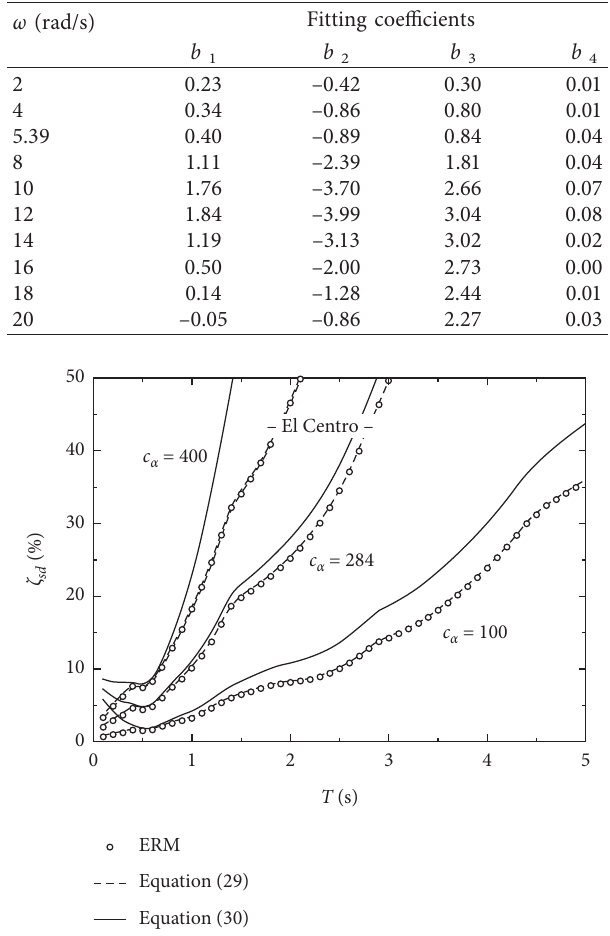
Figure 11: ADR spectra with different values of c El Centro ground motion ( α � 0.50).